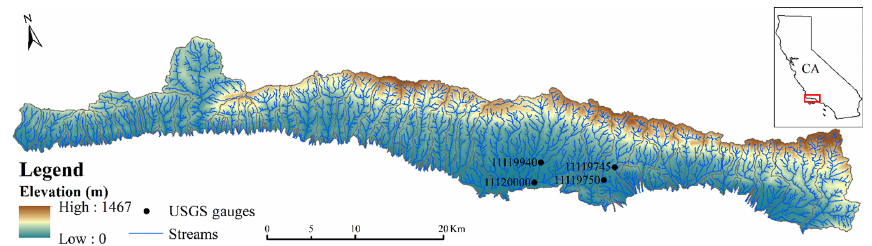
Figure 1. Study region with USGS streamflow gauges. The inset figure indicates the location of SBC in the state of California